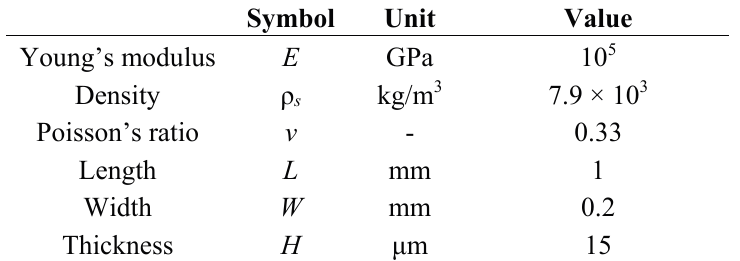
Table 1. Parameters for the MSP used in the numerical simulation.